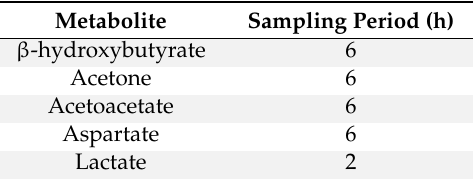
Table 5. Metabolites detected in plasma samples, that discriminated the baseline from treatments (enriched dark chocolate, dark chocolate and white chocolate), and times after intake where increase in measured signal was the highest, in an untargeted study